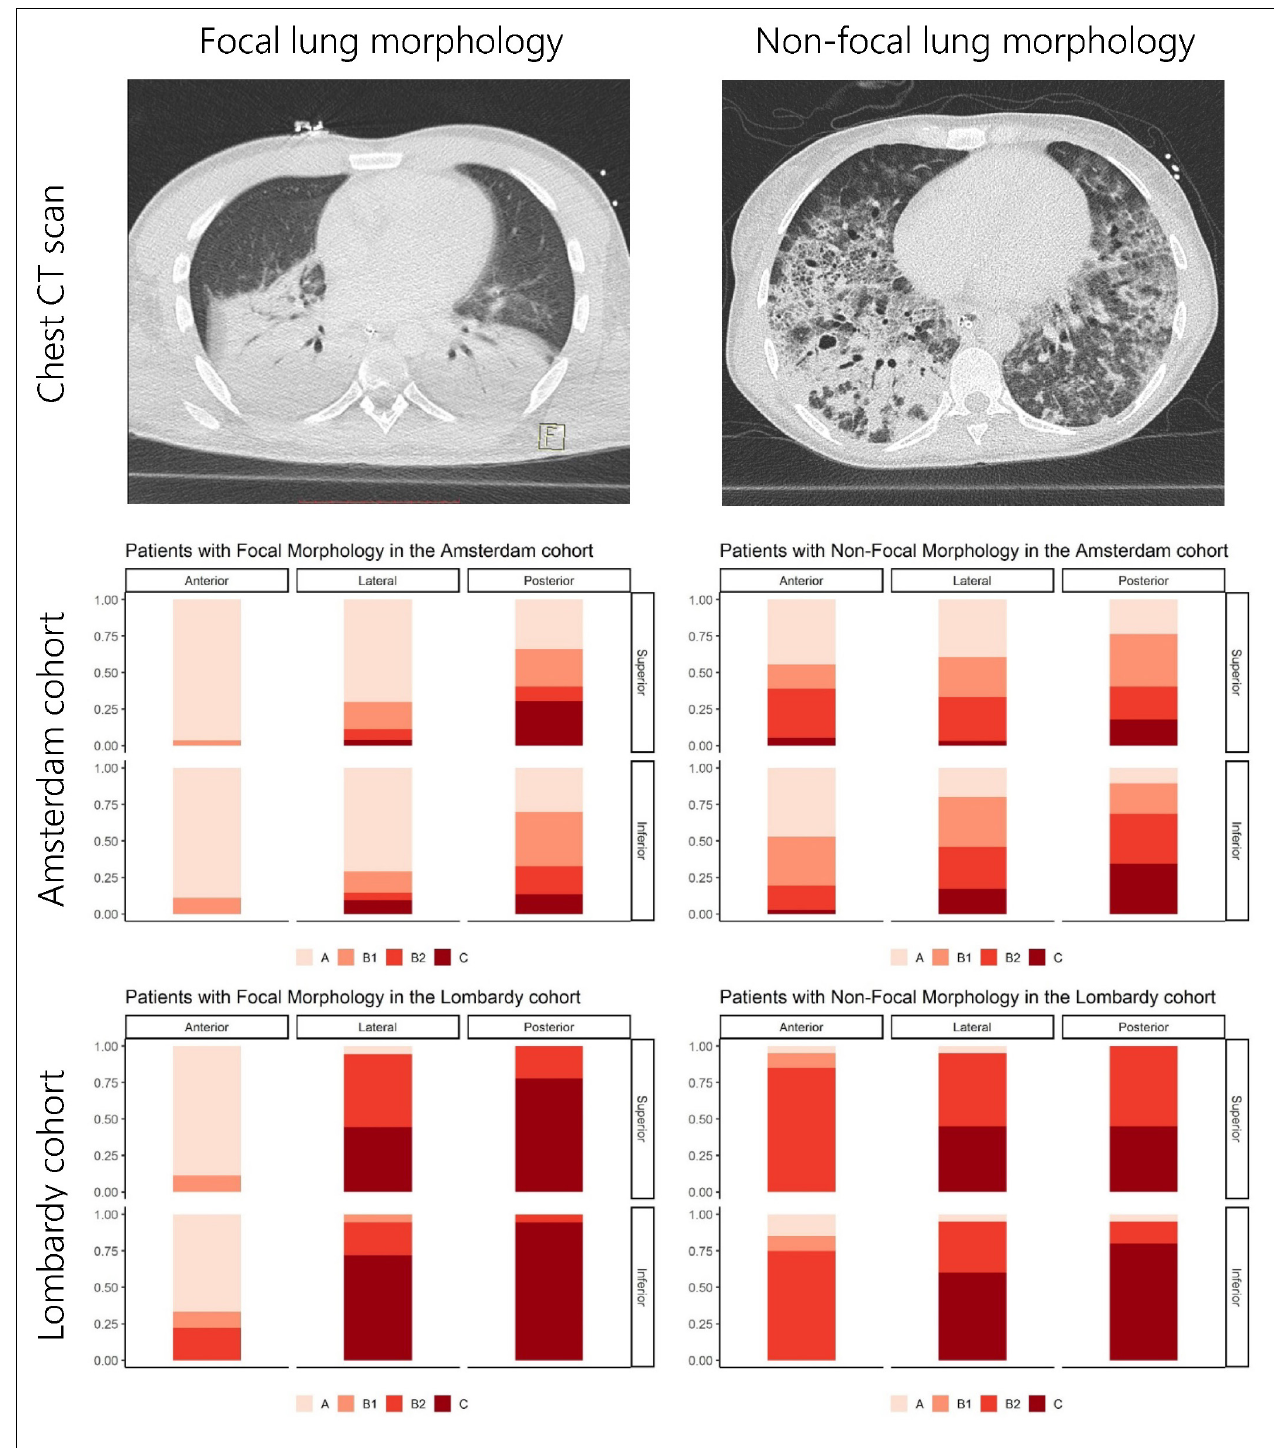
FIGURE 1 | Overview of LUS patterns present per lung region for the Amsterdam and Lombardy cohorts. The upper images show examples of CT images from patients with focal and non-focal lung morphology. The middle and lower figures show the distribution of LUS patterns [A-pattern (score 0), B-patterns (scores 1 and 2), and C-patterns (score 3)] for the anterior, lateral, and posterior lung regions stratified for lung morphology as assessed by CT and cohort. LUS, lung ultrasound; CT, computed tomography.